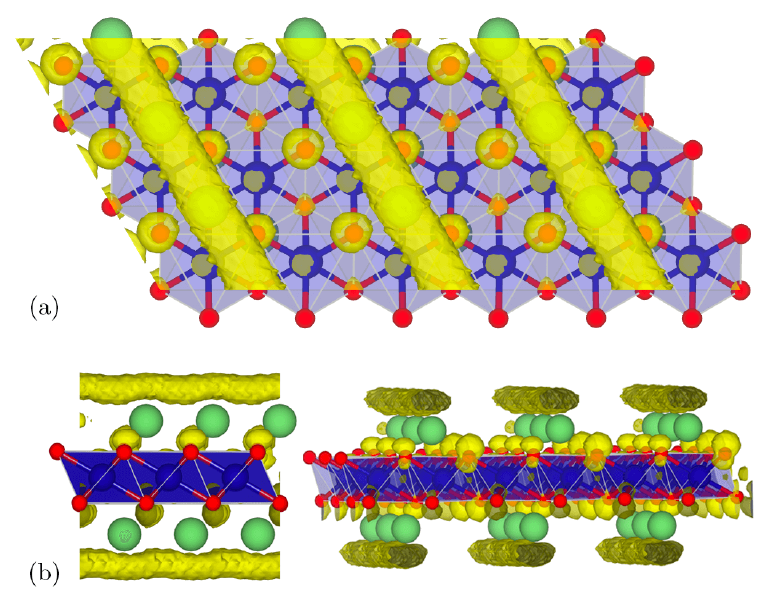
Figure 7: 2D electron density in case of CoO arranged in rows of Li, achieving one Li per CoO density correspond to 1.04 × 10 − 5